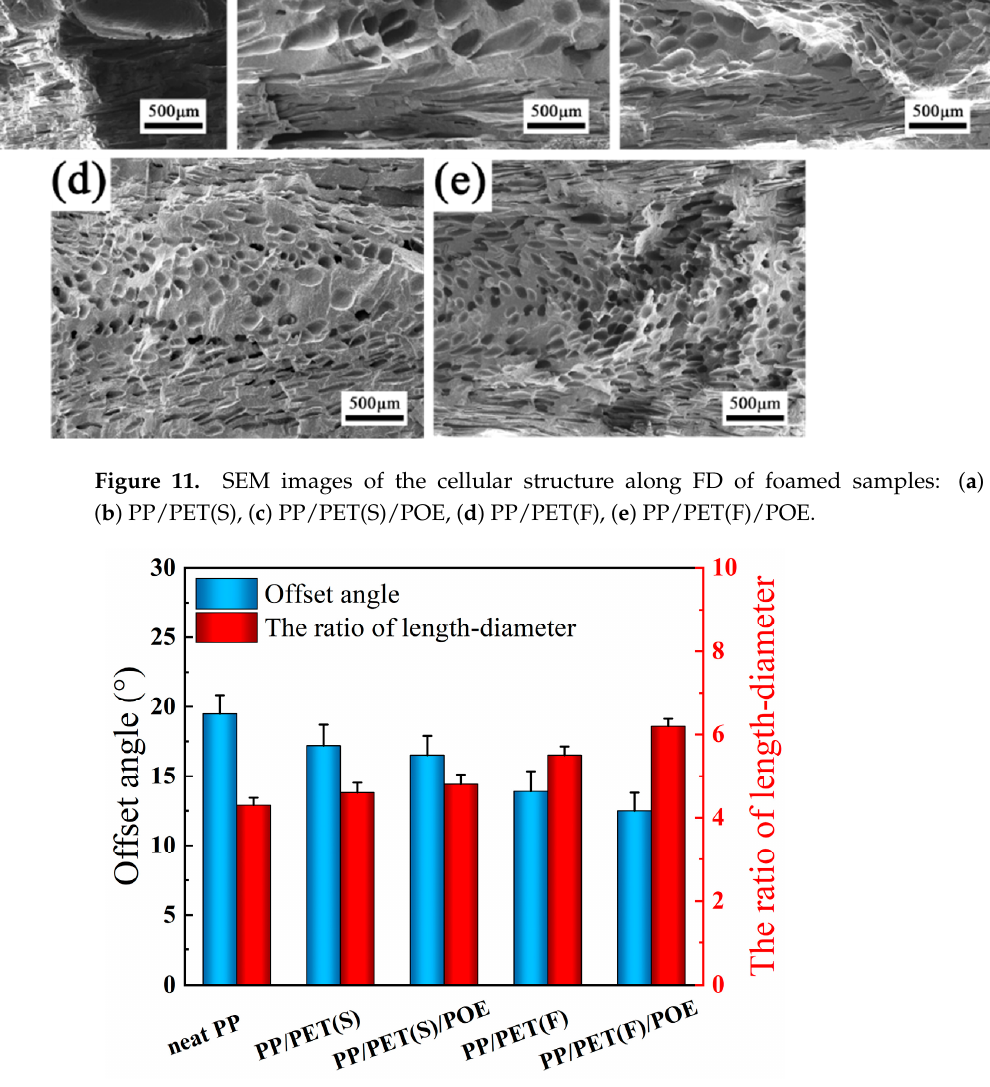
Figure 12. Cellular offset angles and length–diameter ratios of cells in shear layer along FD for different foamed samples.